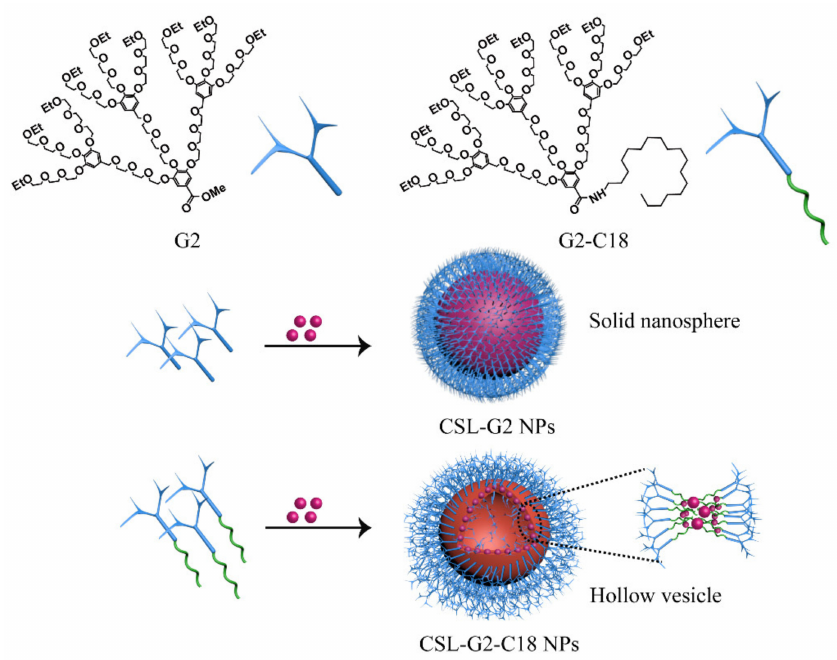
Figure 1. Chemical structure of nanocarriers G2 and G2-C18, CSL NPs cartoon illustration.